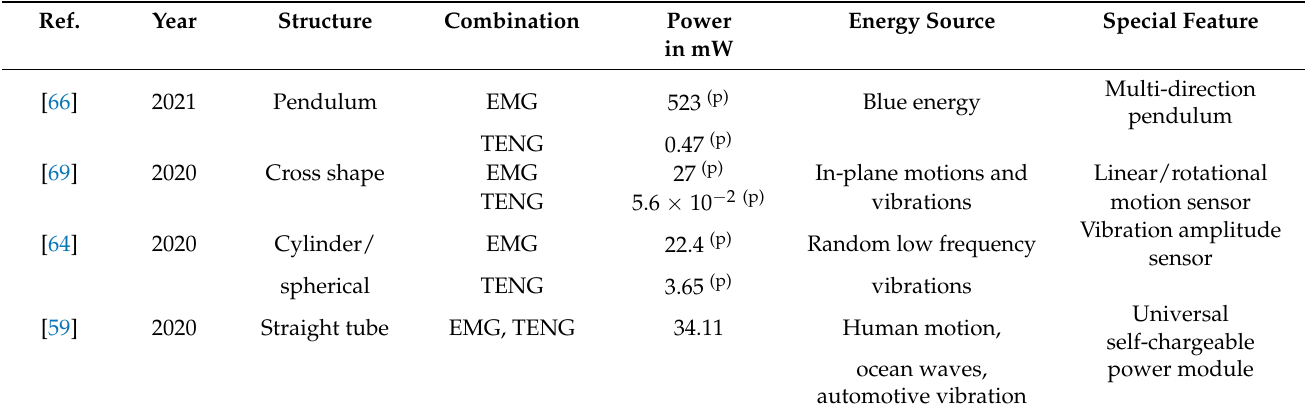
Table 3. 3D printed electromagnetic hybrid vibration harvesters in the literature.